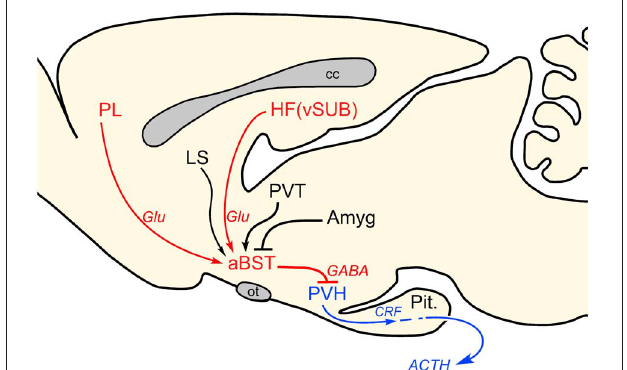
FIGURE 5 | Proposed role of anterior bed nuclei of the stria terminalis (aBST) as an integrator of limbic forebrain influences on emotional stress-induced HPA output. Previous work of ours supports the pathways highlighted in red, with aBST providing an important source of GABAergic innervation of PVH, and relaying limbic cortical influences. Other forebrain cell groups known to influence HPA output (highlighted in black), notably via GC receptor-mediated negative feedback, also project to aBST, whose integrated output targets PVH directly. Like ventral subiculum (vSUB) and prelimbic cortex (PL), these regions do not provide any appreciable innervation of PVH, but do issue projections to the aBST. ACTH, adrenocorticotropic hormone; Amyg, amygdala; cc, corpus callosum; CRF, corticotropin-releasing factor; Glu, glutamate; HF, hippocampal formation; LS, lateral septum; ot, optic tract; Pit., pituitary gland; PVH, paraventricular nucleus of the hypothalamus; PVT, paraventricular thalamic